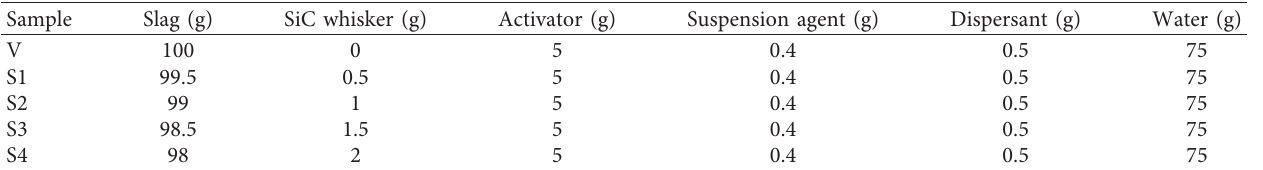
Table 4: Formulations of the base slurry.